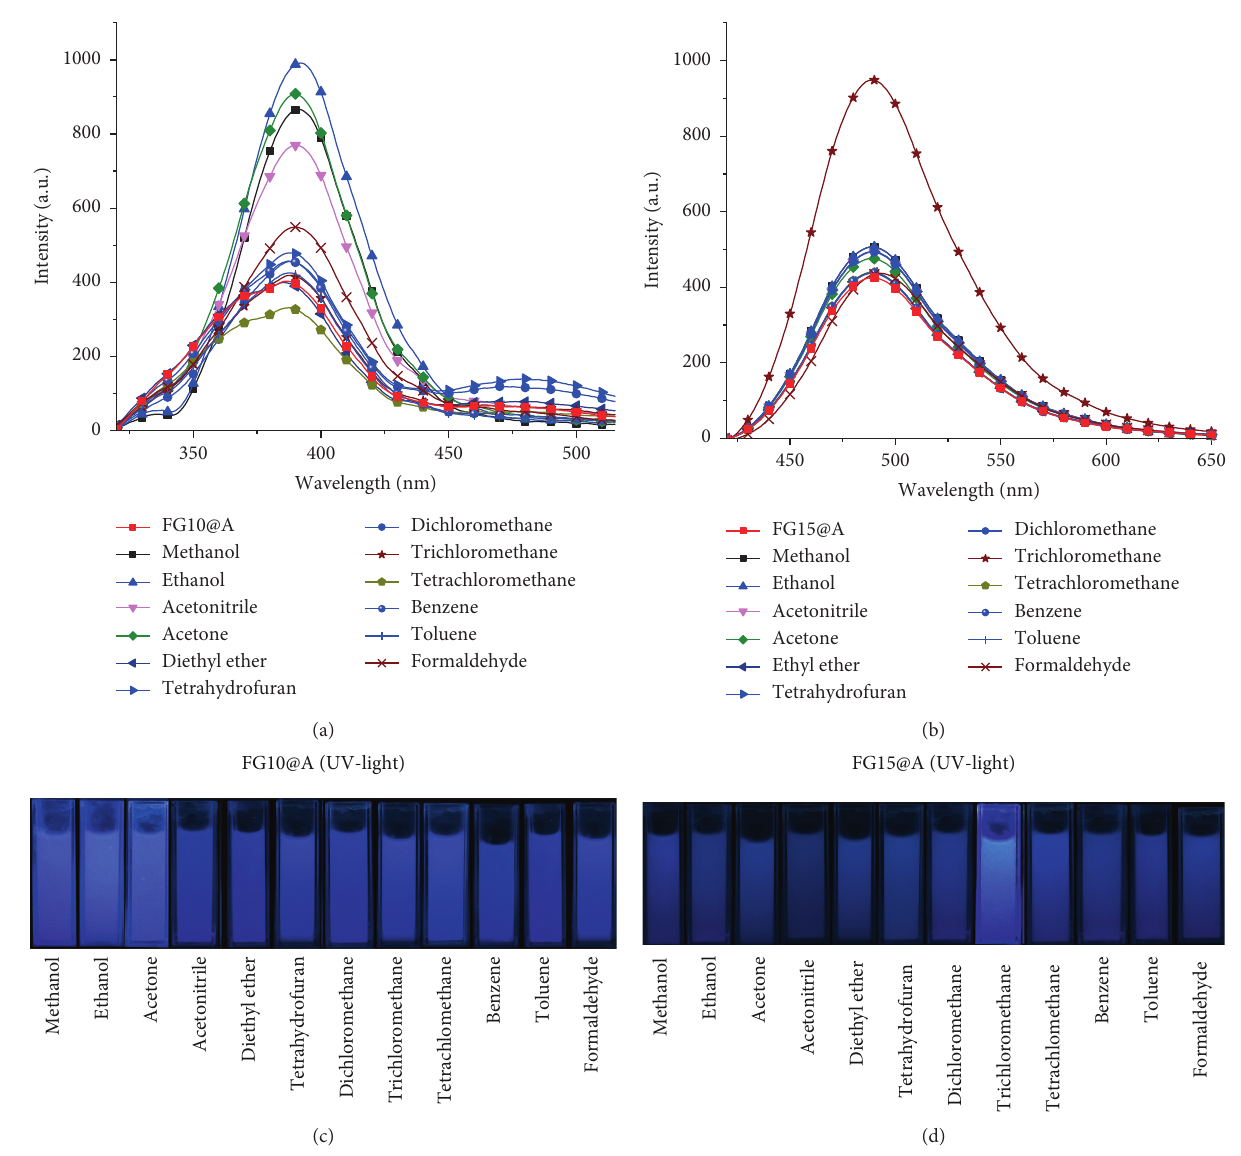
Figure 4: Fluorescence spectra of (a) FG 10@ A ; (b) FG 15@ A loaded with the 12 VOC s, respectively; (c, d) the corresponding photographs of FG 10@ A and FG 15@ A containing selected VOC s under UV light (365